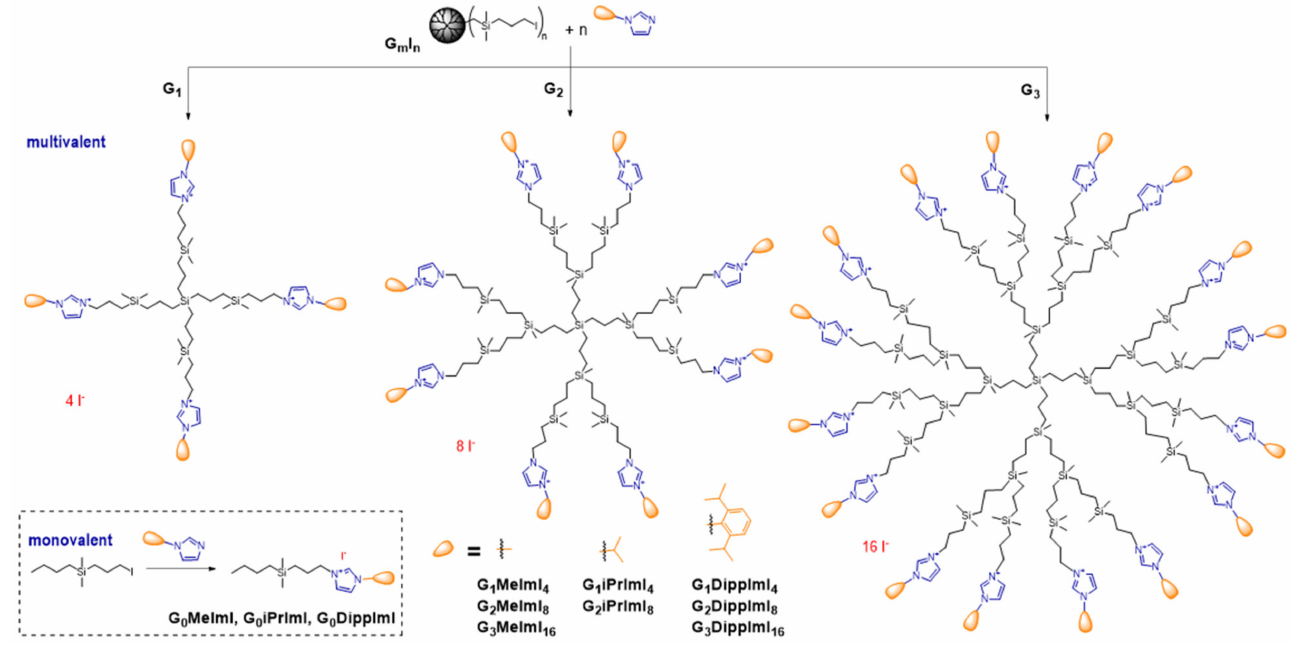
Scheme 1. Synthesis of model and dendritic imidazolium